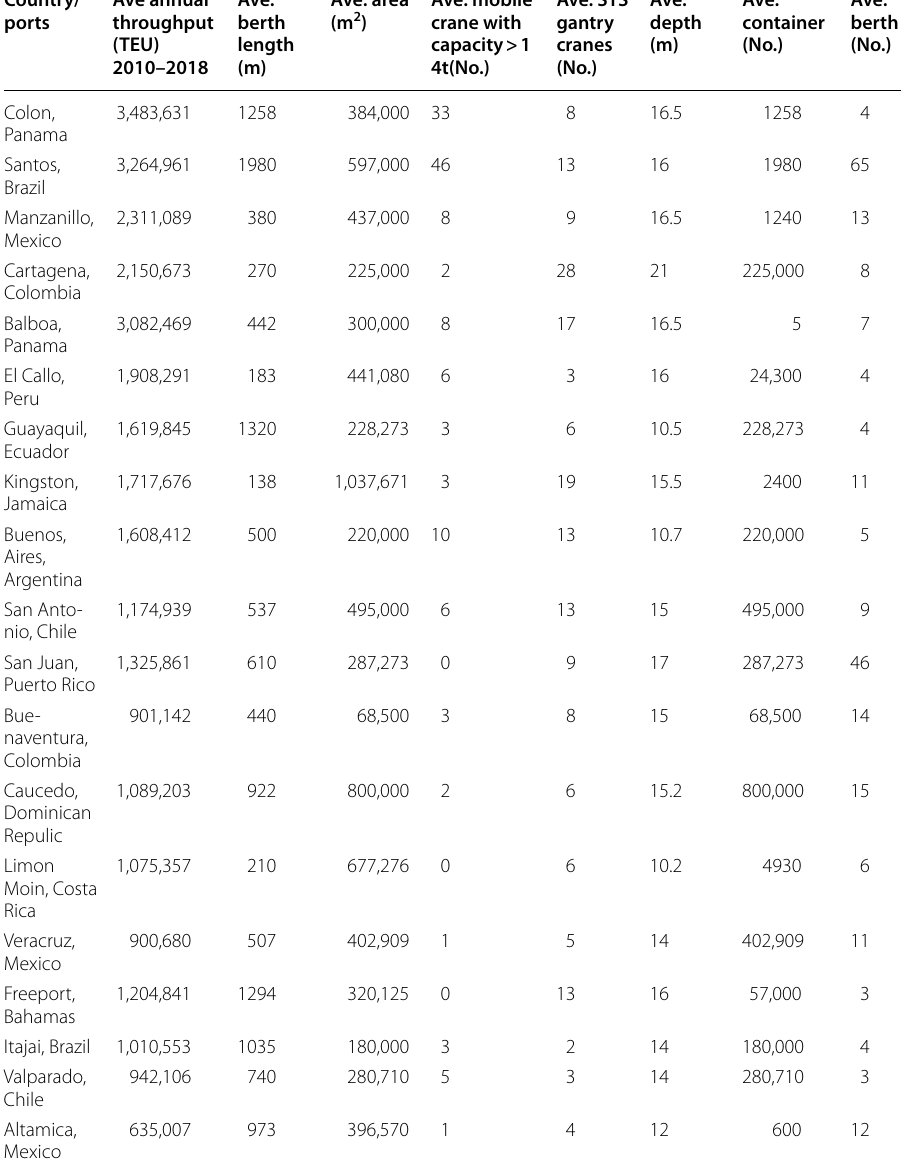
Table 3 Key port infrastructural indicators for the 19 LAC ports. Source : Own elaboration Country/